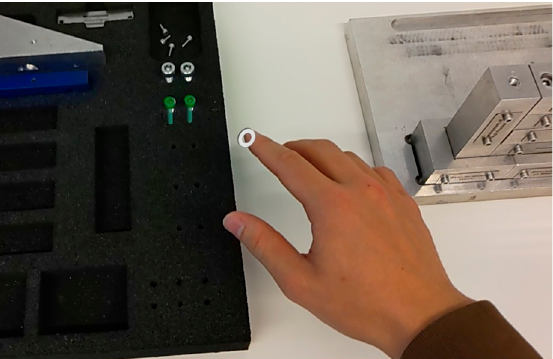
Figure 9. Screenshot of index finger being tracked. The white circle indicates the tracked index finger position. finger